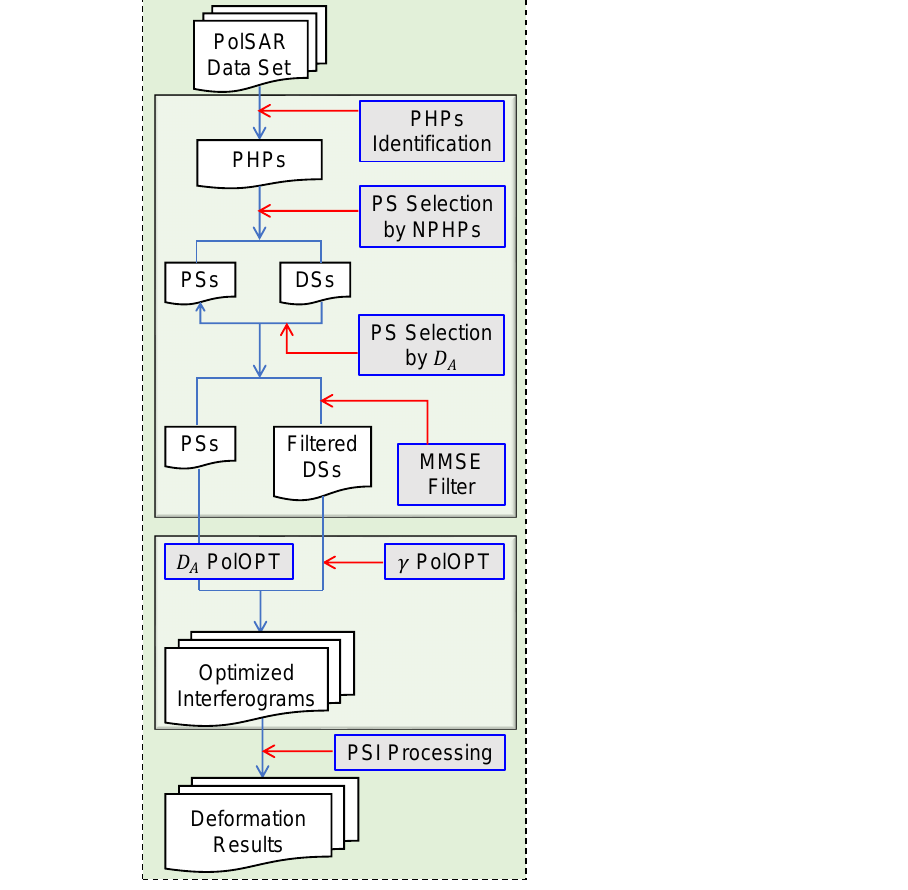
Figure 1. Flowchart of the Polarimetric Persistent Scatterer Interferometry with the Adaptive Opti- mization Strategy (PolPSI-AOS). The abbreviation PHPs, NPHPs, PSs, DSs, MMSE filter, and PolOPT represents the polarimetric homogeneous pixels, the number of polarimetric homogeneous pixels, per- sistent scatterers, distributed scatterers, the minimum mean square error filter, and the polarimetric optimization,